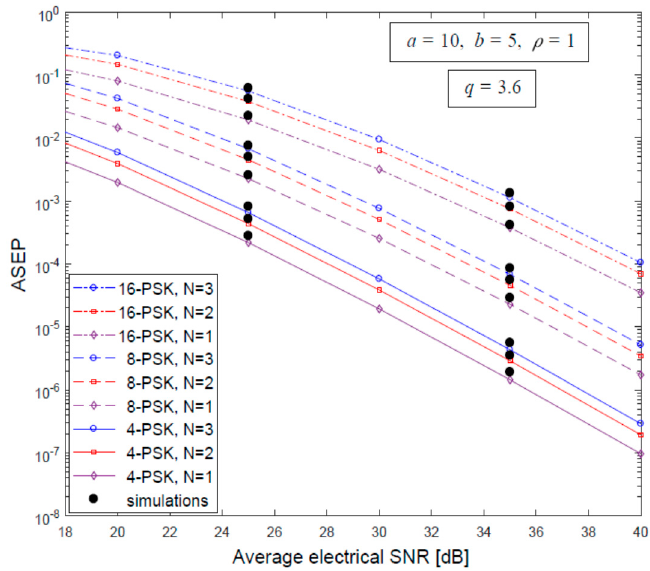
Figure 1. Average symbol error probability (ASEP) versus the average electrical signal-to-noise ratio(SNR) of single-hop or multi-hop free-space optics (FSO) configurations for weak turbulence strengths, a weak amount of non-zero boresight pointing errors, and various phase shift keying (PSK) modulation formats with negligible phase noise impairments.